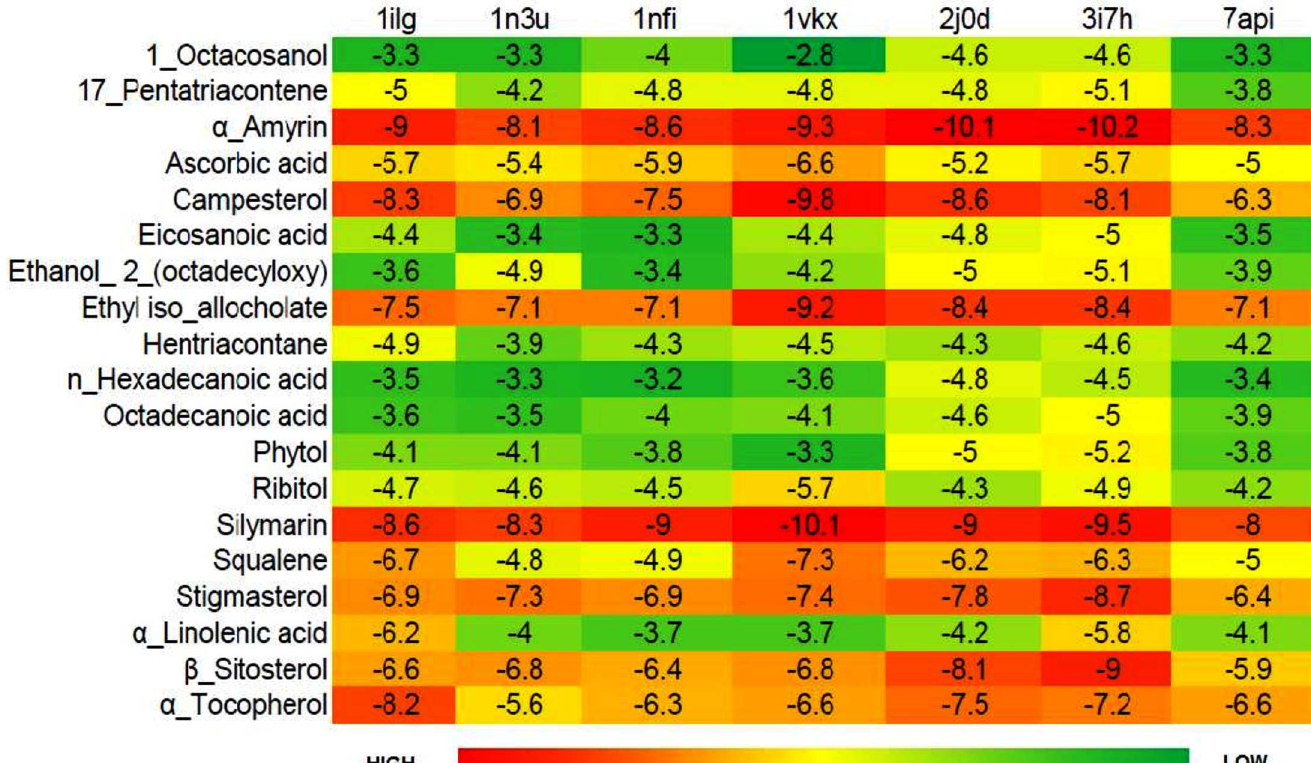
Fig 13. Heatmap based on binding energy among proteins and phytochemicals. The phytochemicals which served as ligands for molecular docking experiment are along the Y axis and the proteins are placed on the X-axis.